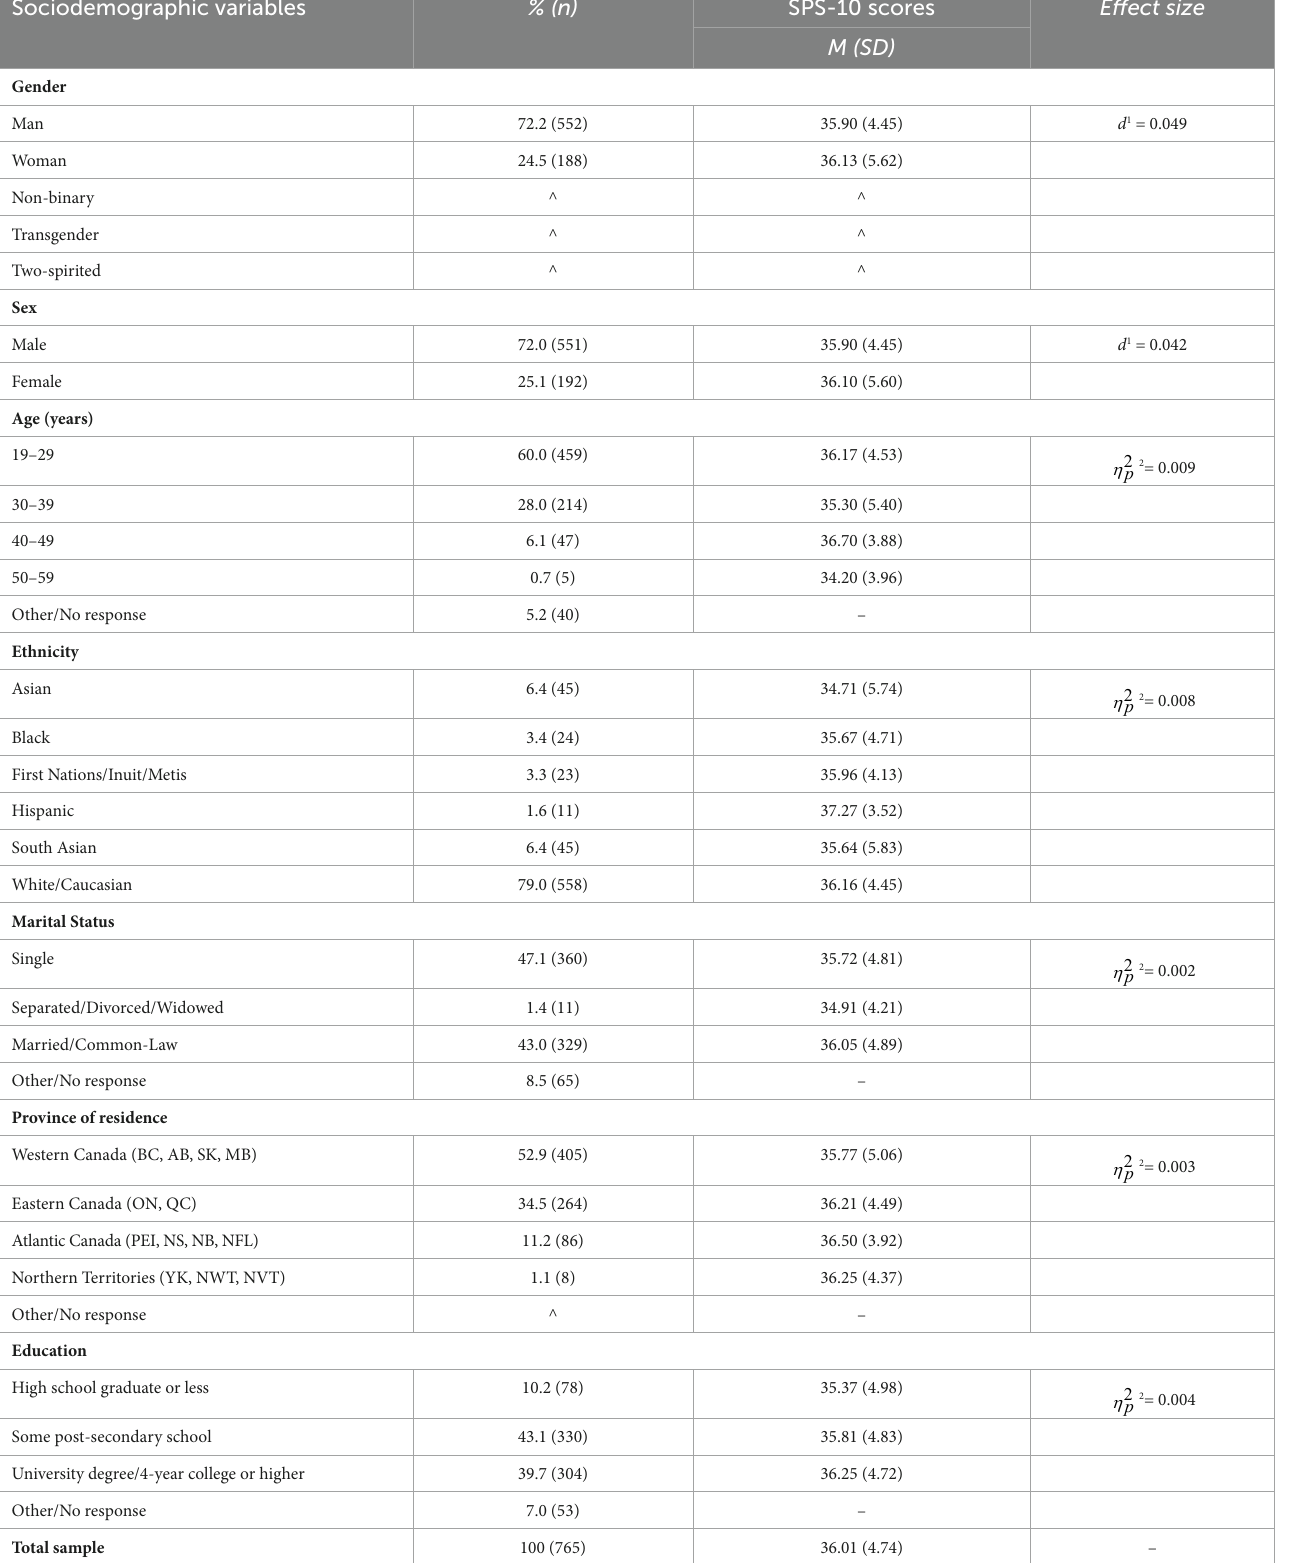
TABLE 1 Frequencies for sociodemographic variables and mean social support scores among RCMP Cadets. Sociodemographic